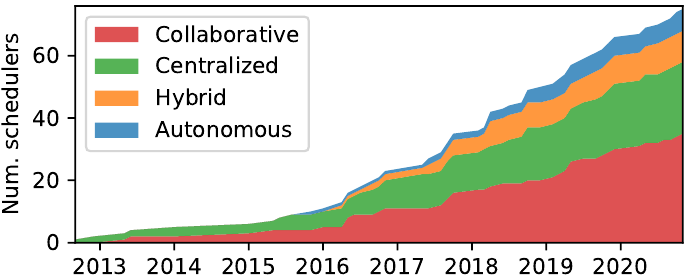
Figure 7. Cumulative distribution of schedulers per